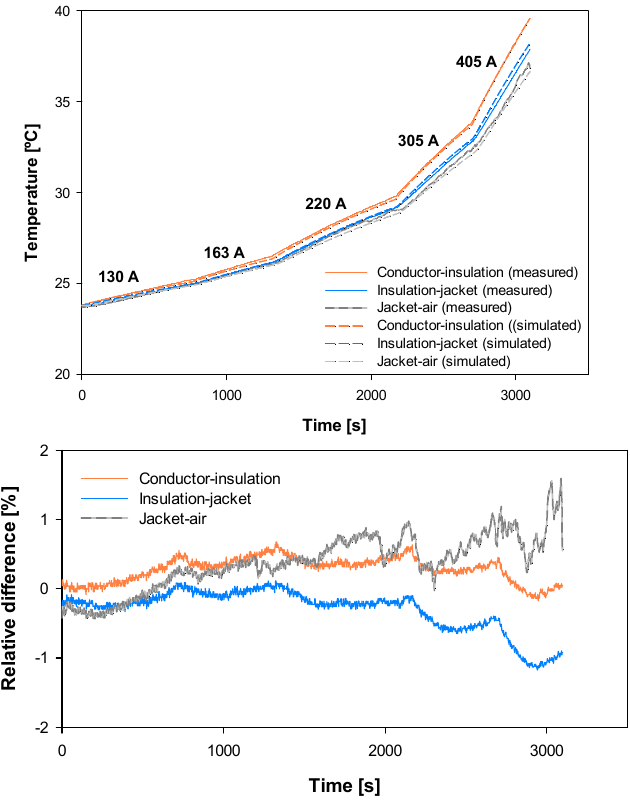
Figure 11. Conductor of 150 mm 2 . Experimental versus simulated temperature rise profiles in the three measured points of the cable (conductor-insulation boundary, insulation-jacket boundary and jacket-air boundary) and the relative difference between the experimental and simulated temperatures.